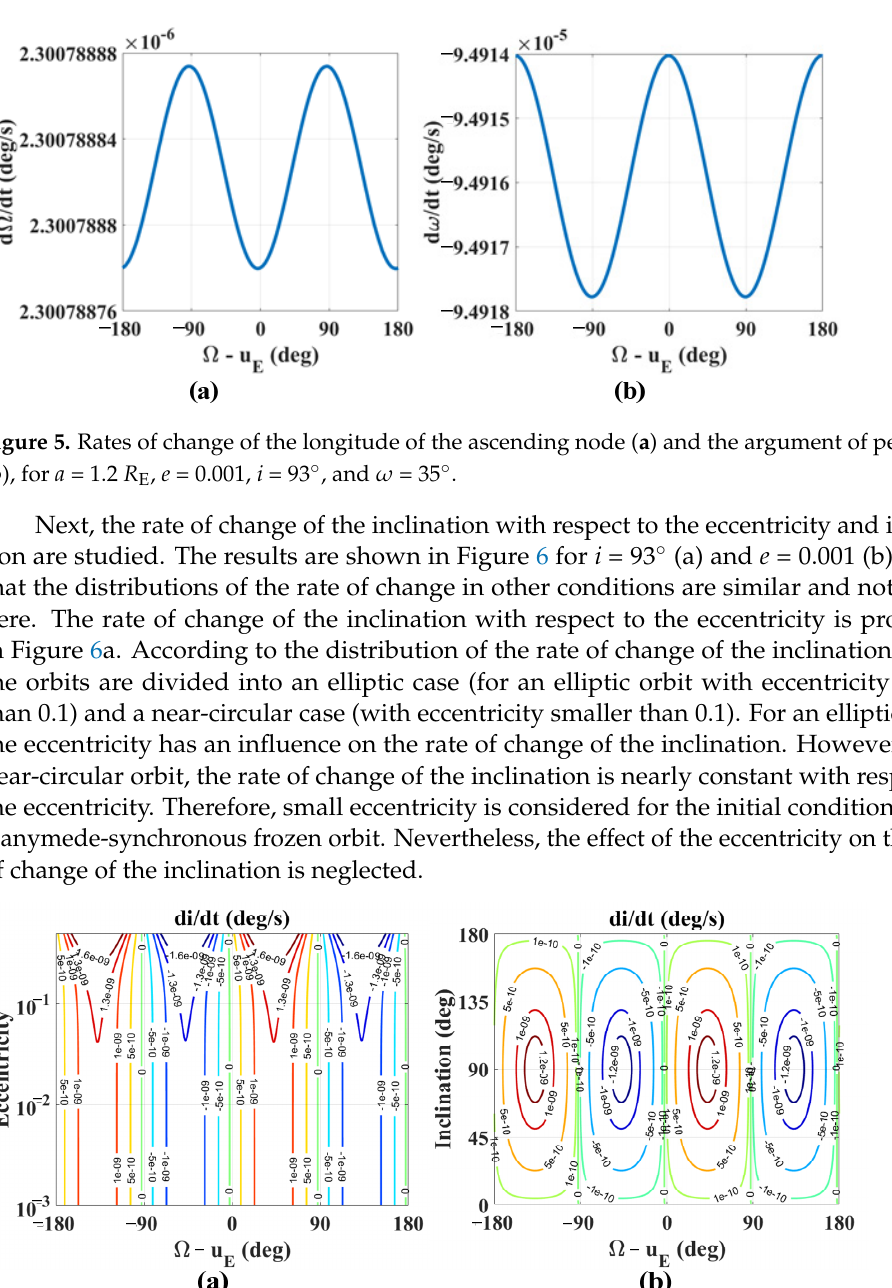
Figure 5. Rates of change of the longitude of the ascending node ( a ) and the argument of periapsis ( b ), for a = 1.2 R E , e = 0.001, i = 93 ° , and ω = 35 ° .